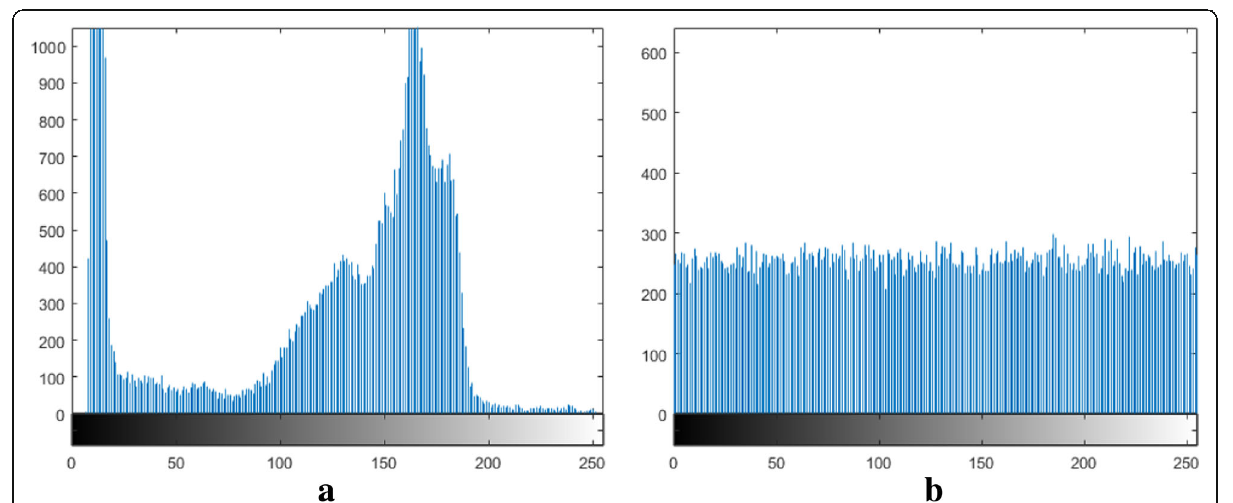
Fig. 4 a Gray histograms of Lena. b Gray histograms of cipher Lena image